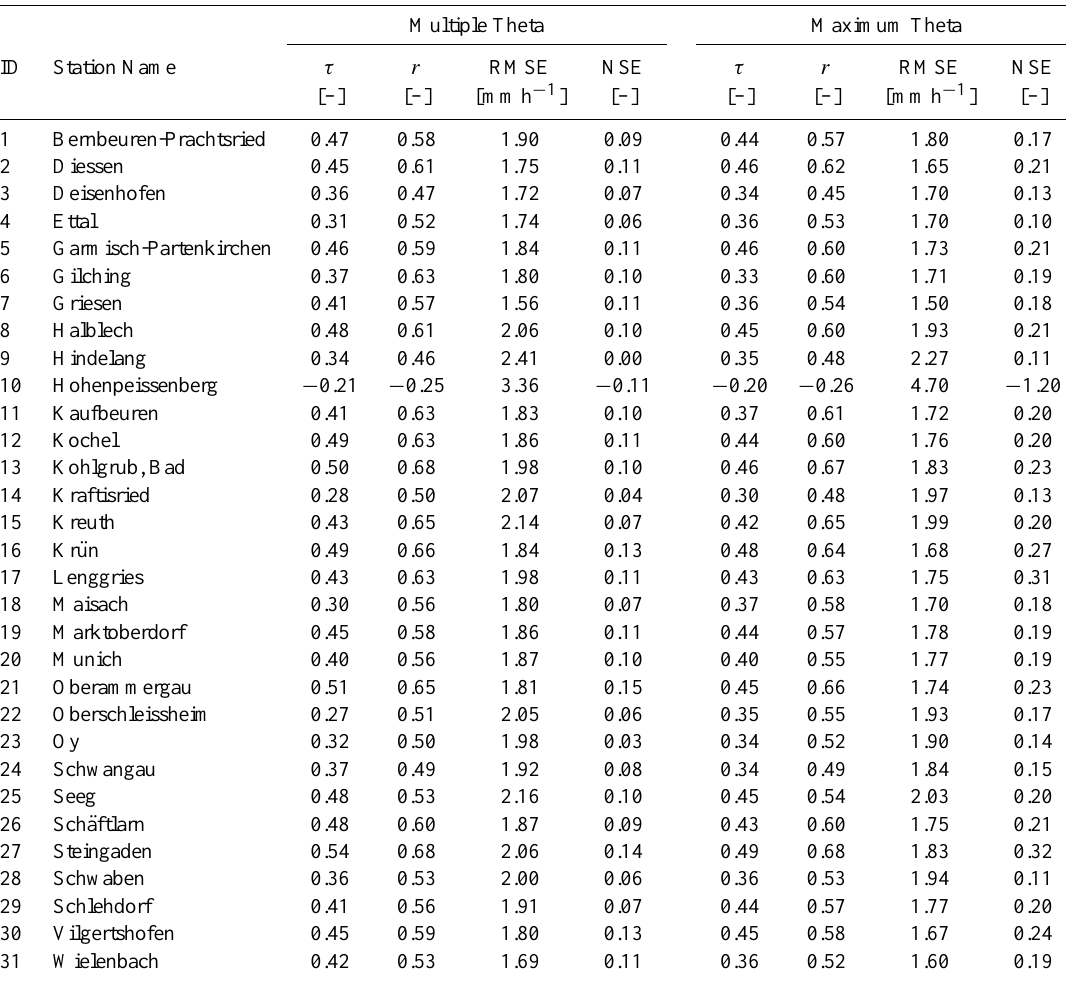
Table B1. Validation of the Multiple Theta and Maximum Theta approach for the 31 stations (summer 2005–2008, wet days